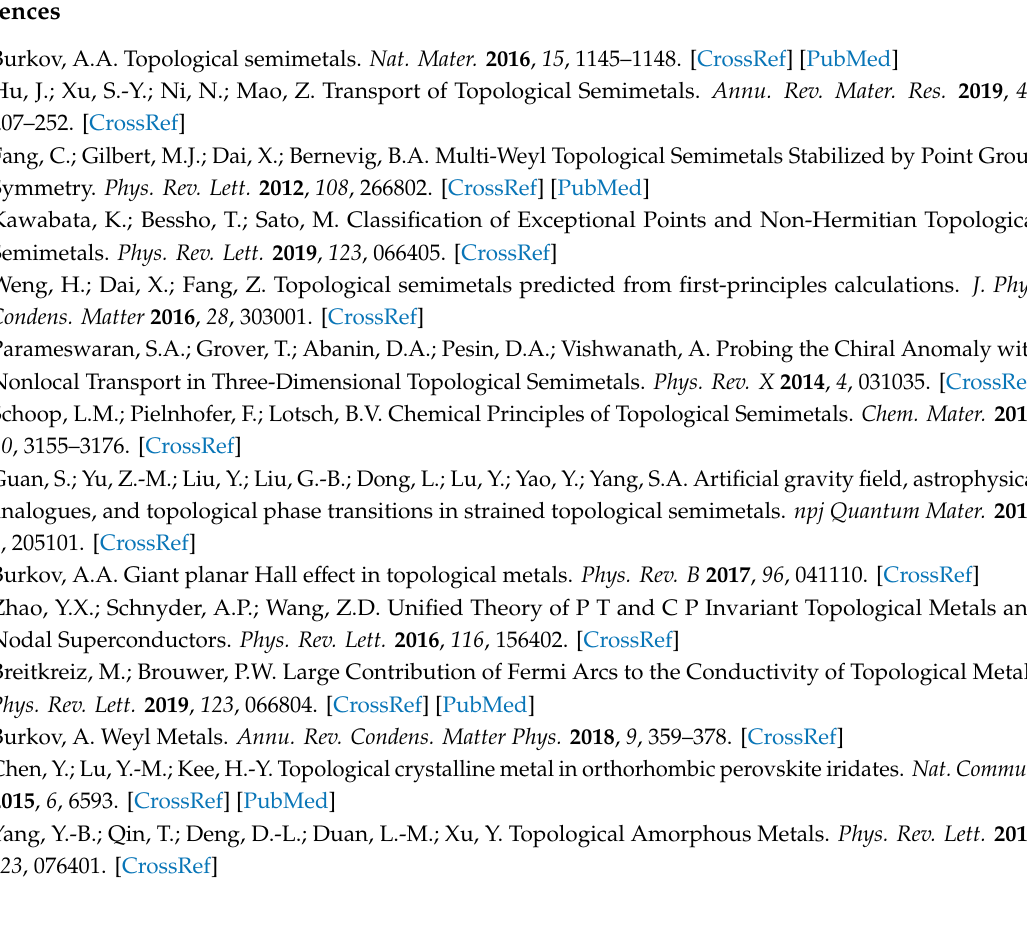
Figure S1: The Berry phase along the M–K– Γ k -path for closed nodal